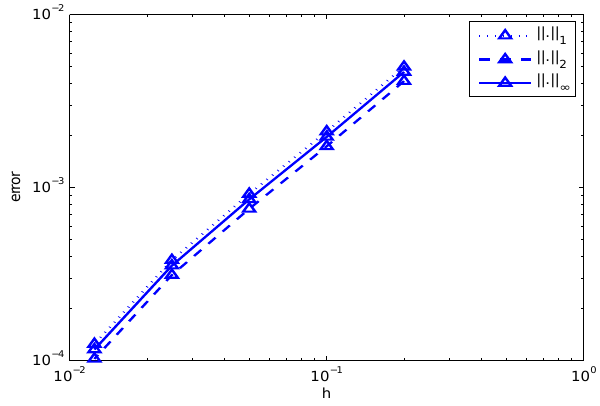
Figure 5. Error for the approximate solution p ( v , t ) plotted in Figure 1.